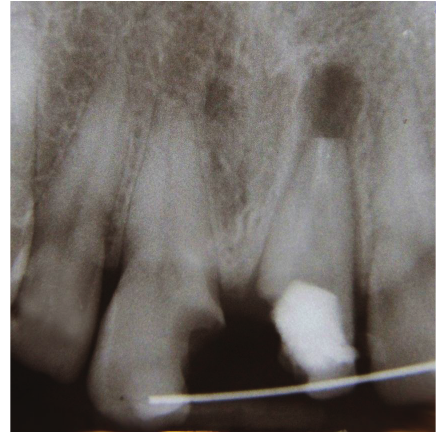
Figure 6: The tooth was immobilized after replantation.